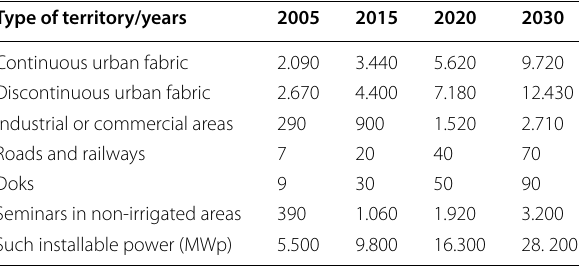
Table 2 Power installable on MWp from 205 to 2030 on Italy. Source: